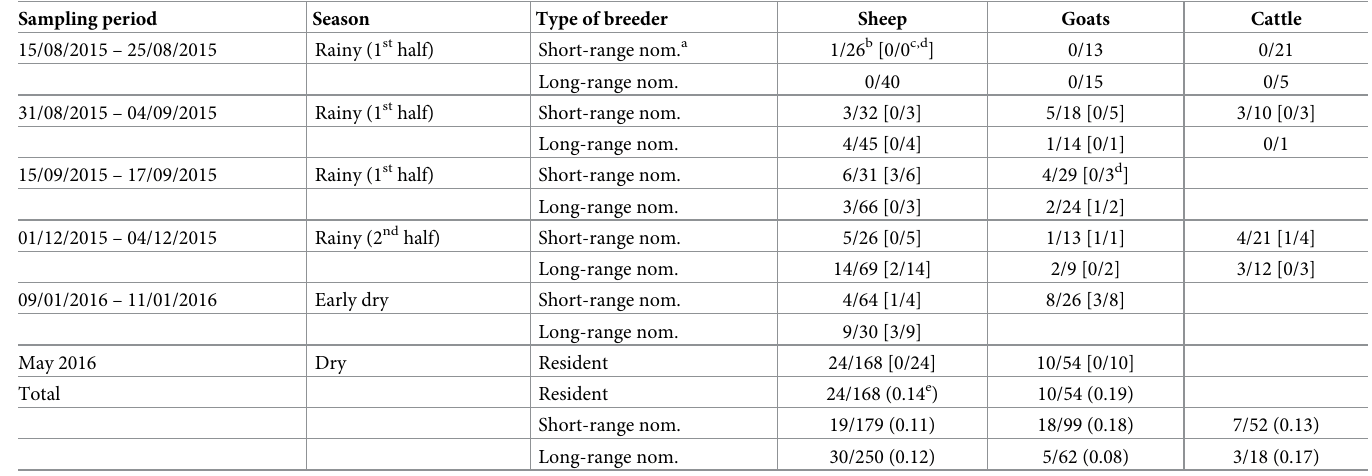
Table 2. Results of serosurveys conducted in ruminants of resident and nomadic herds in Younoufere area, Ferlo, Senegal, May 2015-January 2016. Sampling